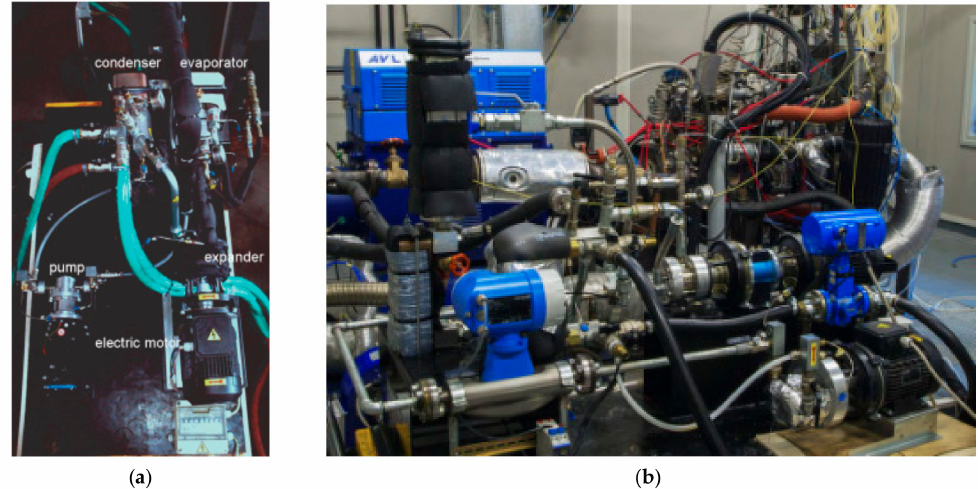
Figure 10. The general views of the ORC test stands implemented at the University of L’Aquila. ( a ) A view of the test stand introduced in [71]—Reproduced with permission from Giuseppe